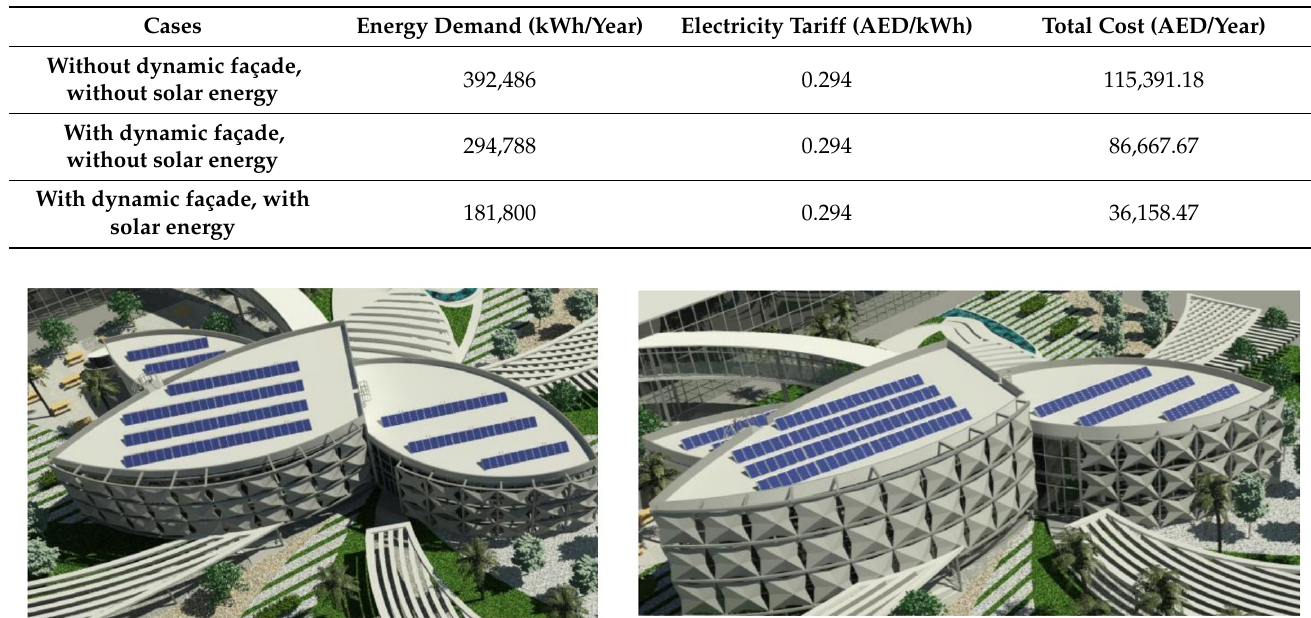
Table 4. Electricity cost calculation.